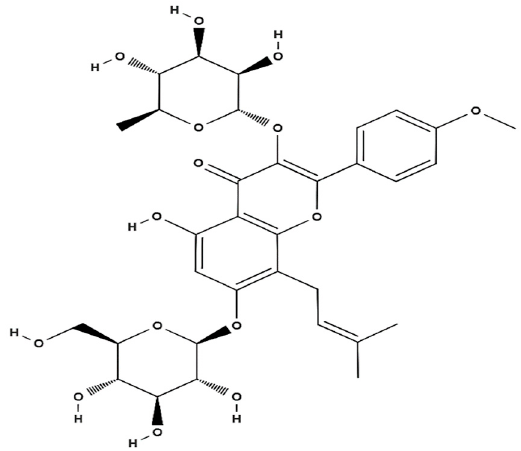
Figure 2. Chemical structure of